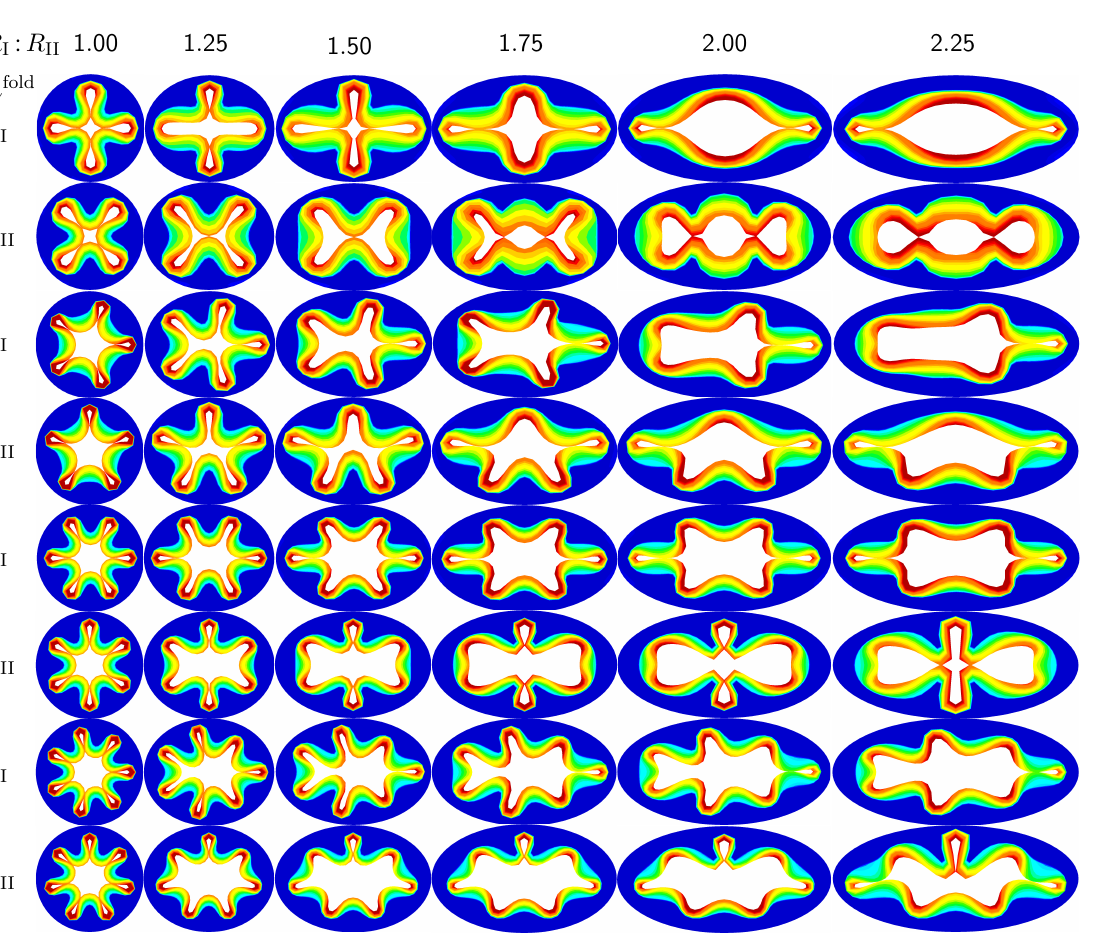
Figure 6. Failure Modes for Varying Cross Section